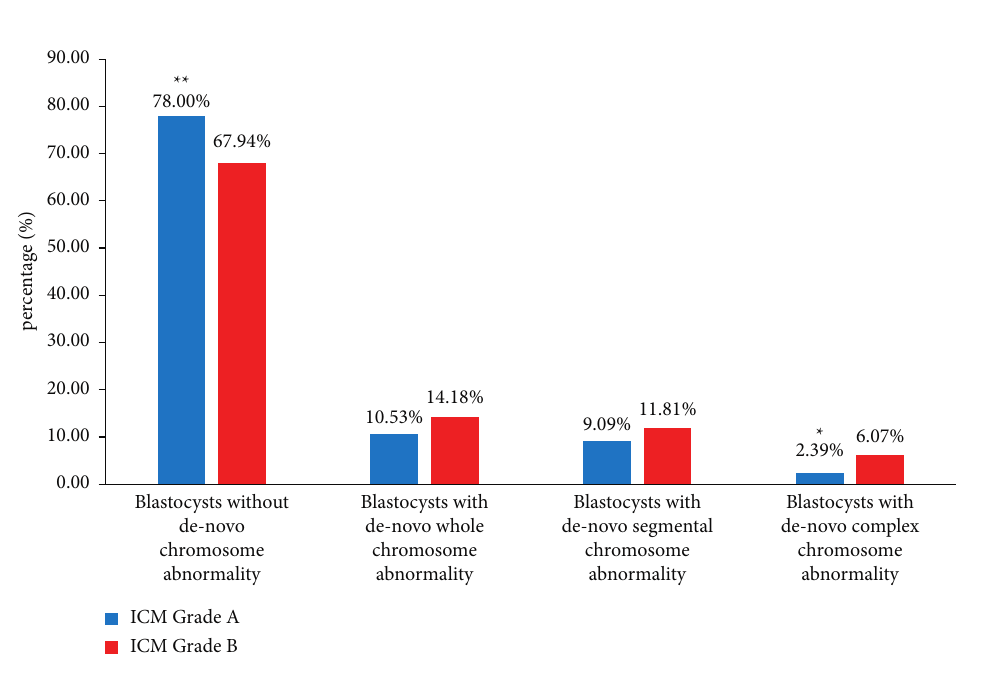
Figure 1: The proportion of blastocysts with different genetic test results related to ICM quality. Data were presented as a percentage. Blastocysts without de novo chromosome abnormality contained euploid, mosaic and chromosome abnormalities inherited from either parent. The proportions between the two groups were tested by the chi-square test. ∗∗ P < 0.01 vs ICM grade B and ∗ P < 0.05 vs ICM grade